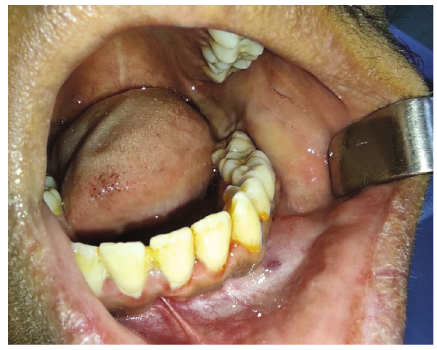
Figure 1: Aspect of the intraoral swelling.